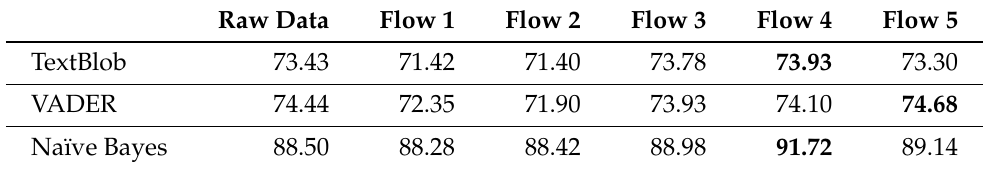
Table 4. Accuracy of the classifiers on the gold